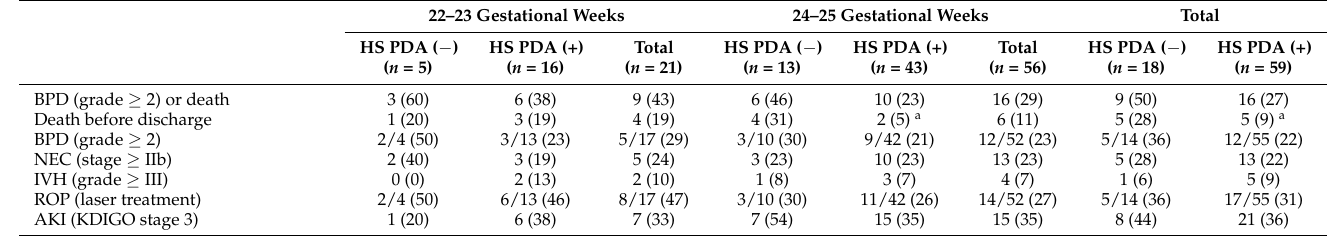
Table 4. Adverse outcomes of the infants with or without HS PDA according to gestational weeks.